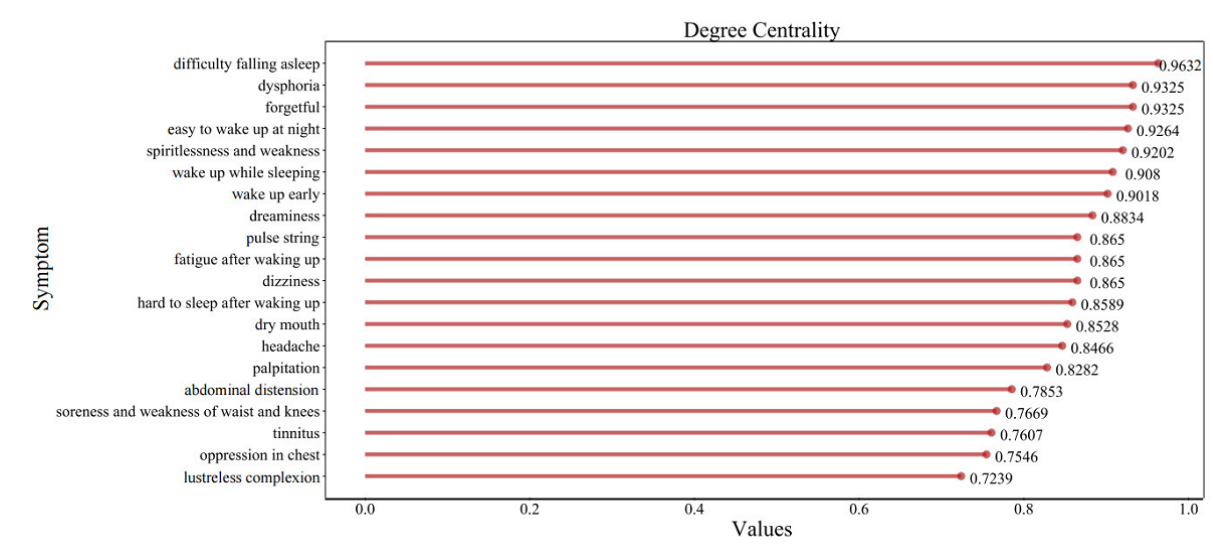
Figure 6. Degree centrality of